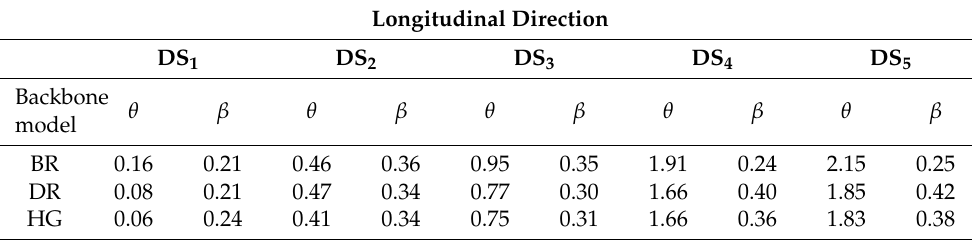
Figure 8. Fragility curves corresponding to the attainment of EMS-98 damage states in the ( a ) longitudinal and ( b ) transverse direction adopting DR, HG, and BR constitutive laws. Table 4. Lognormal fragility curve parameters in the longitudinal direction.